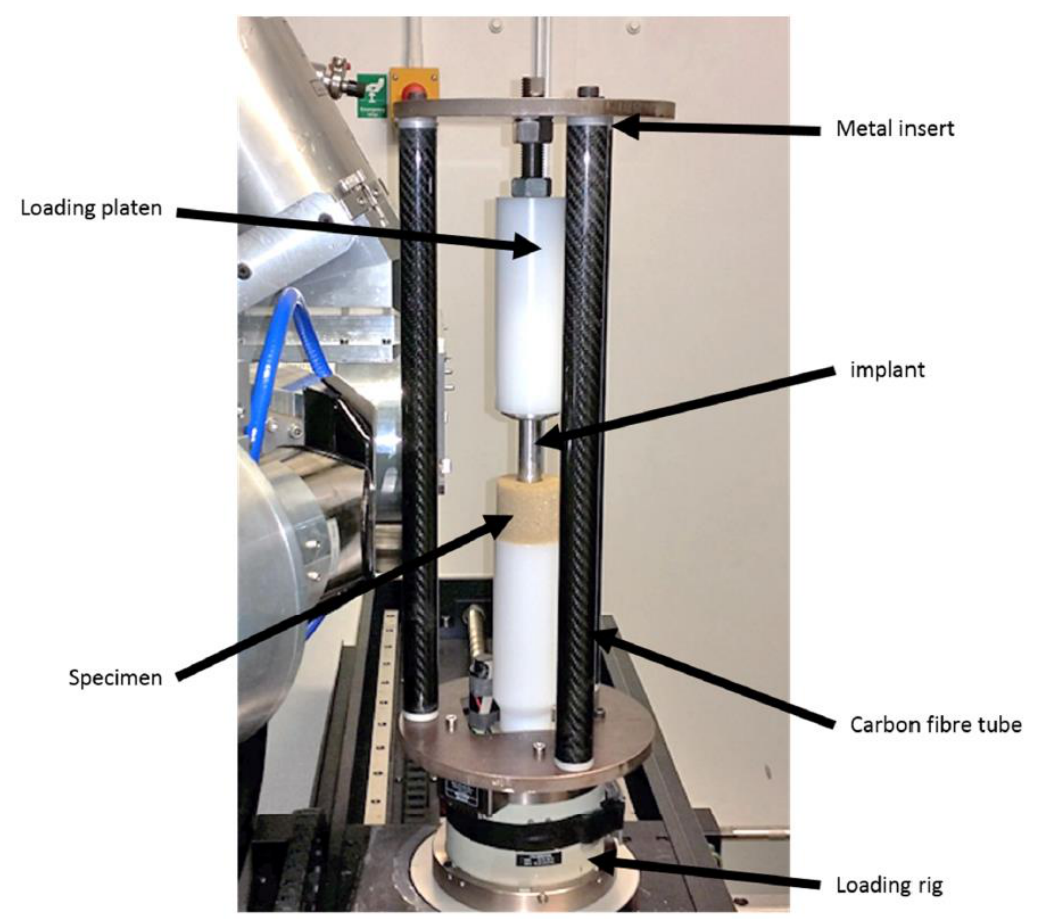
Figure 2. Customised loading rig to recreate process of implantation within micro-CT scanner. An aluminium stem (axisymmetric, non-tapered) was used as a simplified implant. Three carbon fibre tubes were used to minimise rigid body motion. Loading was conducted in displacement-control.